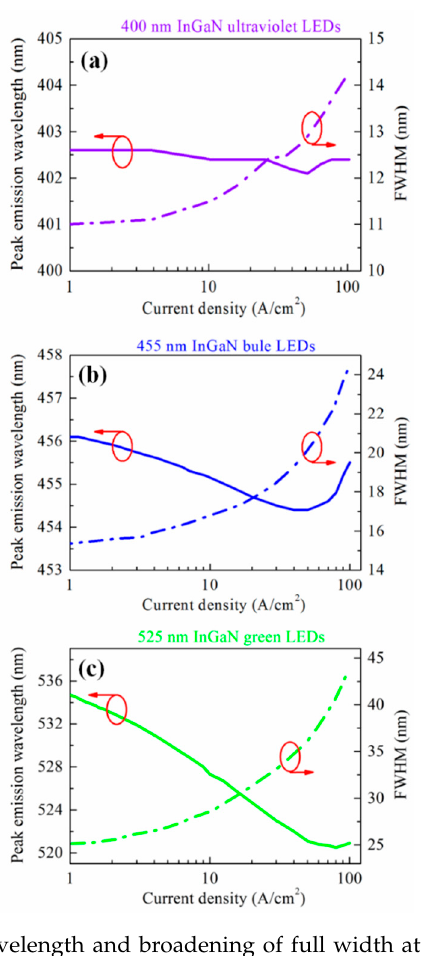
Figure 4. Peak emission wavelength and broadening of full width at half maximum (FWHM) of emission spectrum versus current density for InGaN ( a ) NUV, ( b ) blue and ( c ) green LEDs respectively.